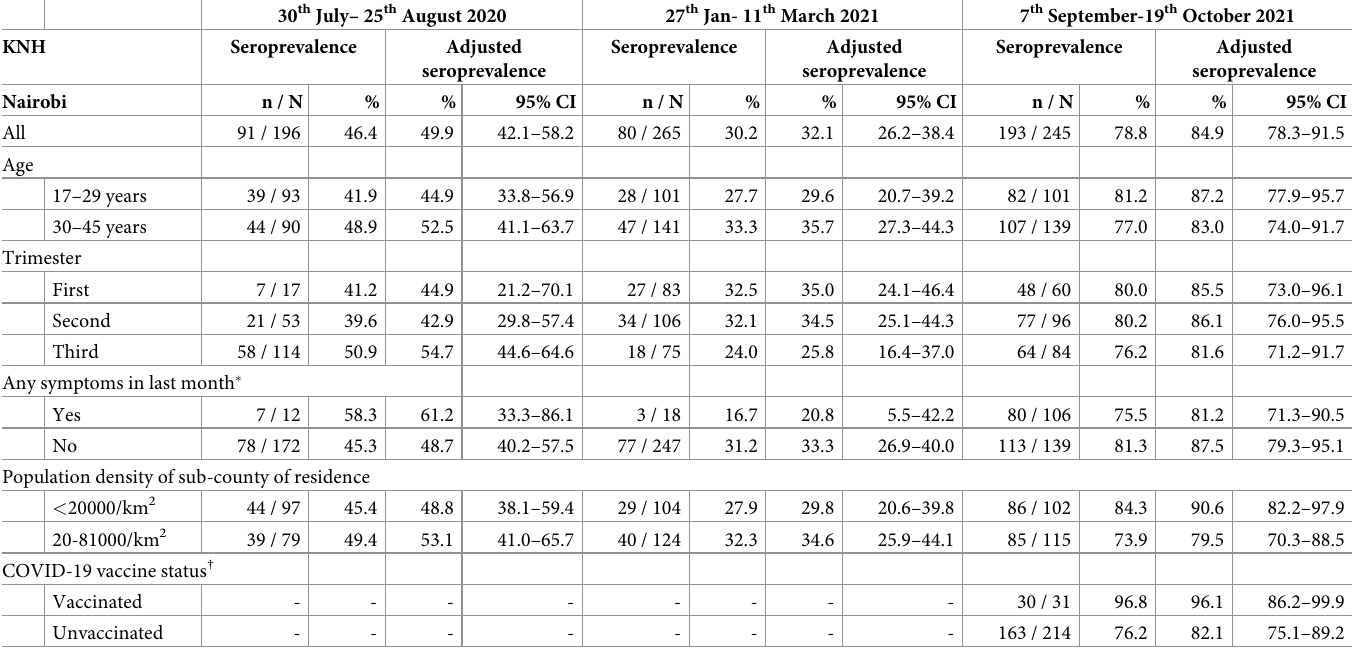
Table 1. Seroprevalence of IgG to SARS-CoV-2 among mothers attending antenatal care in Kenyatta National Hospital (KNH),